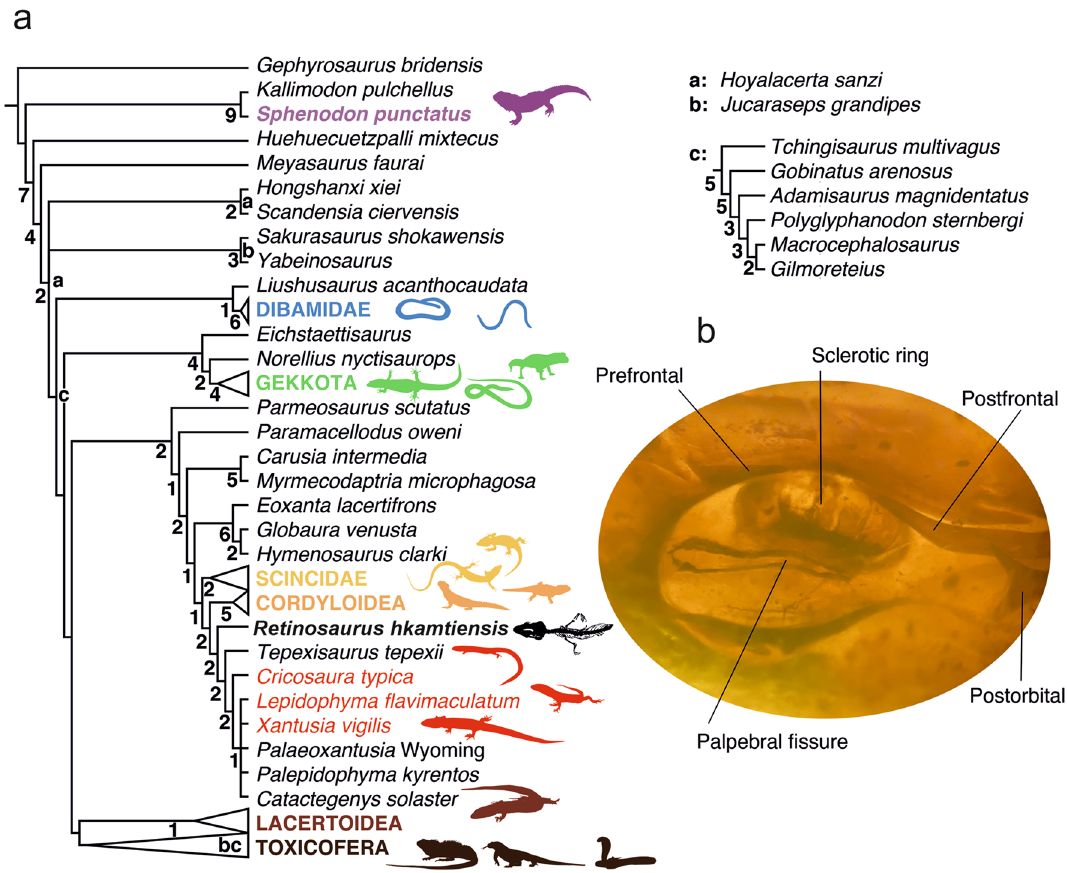
Figure 4. ( a ) Phylogenetic position of Retinosaurus hkamtiensis (GRS 29689) using a combined data set of morphological and molecular data, including all characters (i.e. not coding ontogenetically variable characters of Retinosaurus as ?), and treating characters as additive following Gauthier et al. 2 . Terminals and groups numbered a–c were identified as wildcard taxa, therefore the strict consensus was calculated without them, and their alternative positions indicated in the tree. Using the combined data set, R. hkamtiensis was recovered as a stem-xantusiid. Numbers below nodes indicate Bremer support values. Letter at nodes indicate alternative positions of wildcard taxa (right). Nodes with no support values were collapsed when wildcards were included in the consensus. ( b ) Inset left side of R. hkamtiensis showing the preservation of the eyelids and circumorbital